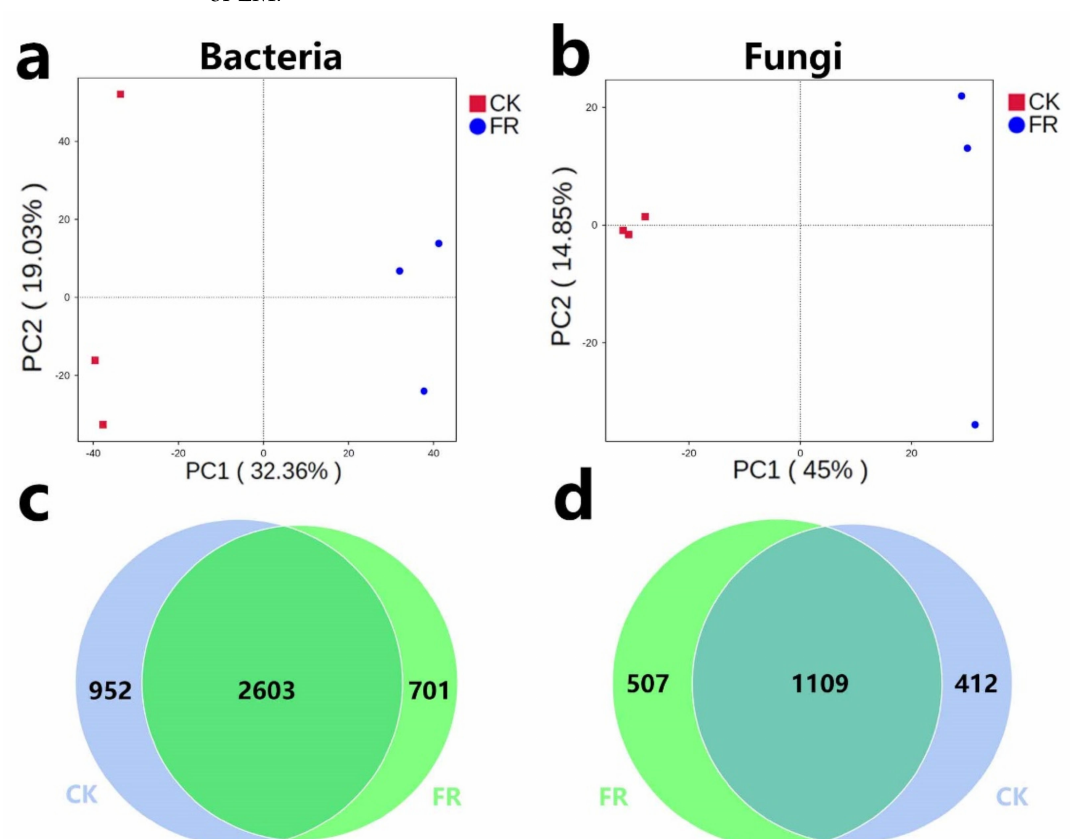
Figure 3. PCA and Venn analysis of bacteria and fungi in the FR and CK zones of the fairy ring ecosystem. ( a , b ) PCA of the bacterial and fungal OTUs in the FR and CK soils. The colored dots in the figures represent the different sample groups. ( c , d ) Venn analysis of the bacterial and fungal